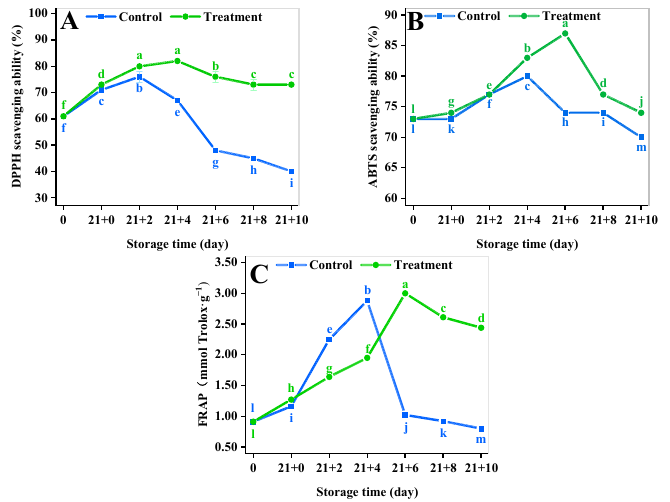
Figure 7. Effect of different storage methods on DPPH ( A ), ABTS ( B ), and FRAP ( C ) of yellow peach. Vertical bars represent standard deviations. Different letters represent statistical differences ( p <